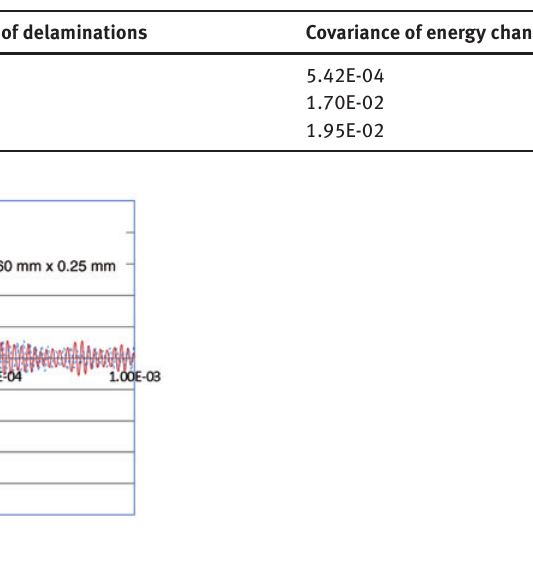
Table 7: Covariance of energy change from multiple